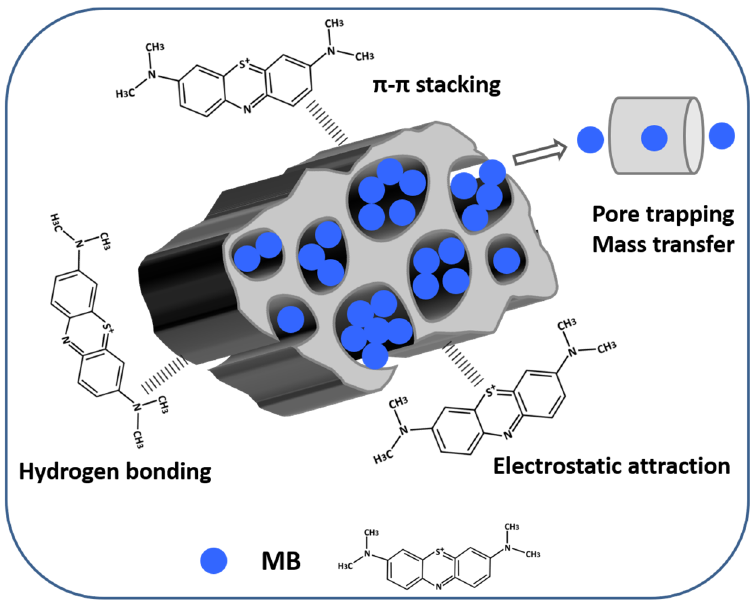
Figure 4. Adsorption mechanism diagram of SPVPC towards MB.